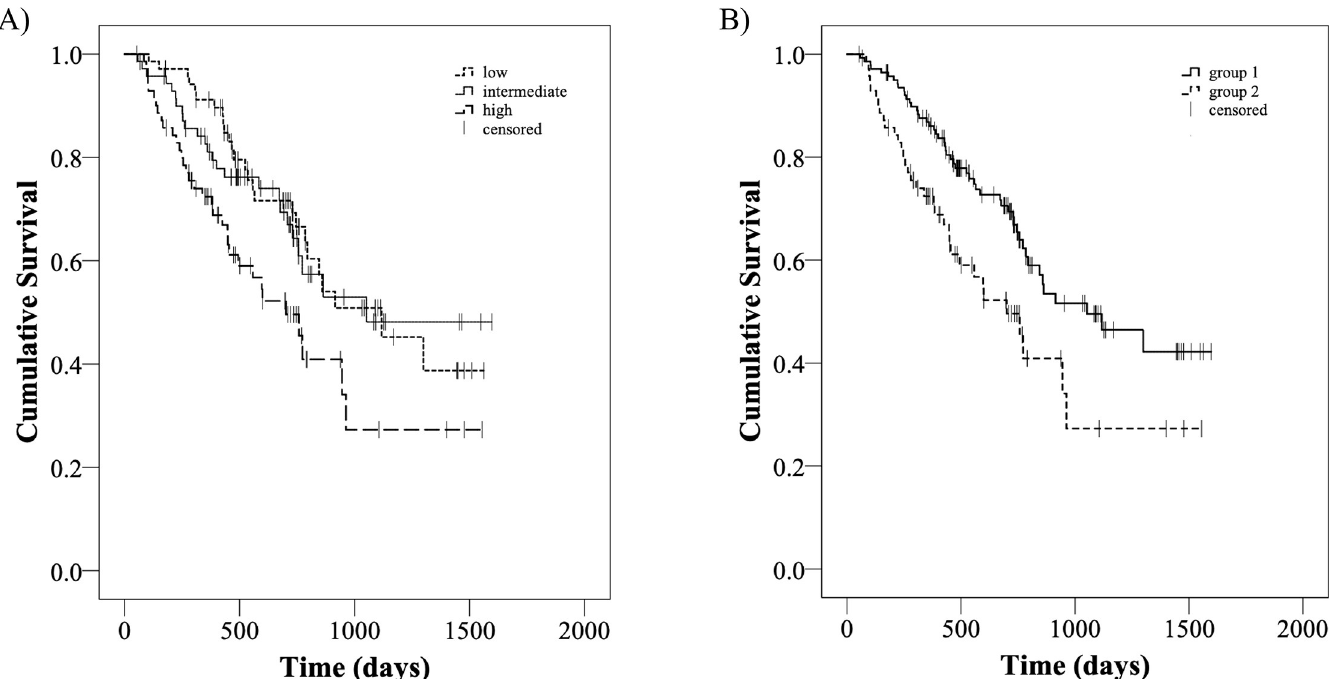
Fig 4. Kaplan-Meier survival curves of the cohort used in this work. Patients divided in a) low-risk group (zone distance varianceGLDZM from 0.15 to 0.85), intermediate-risk group (zone distance varianceGLDZM from 0.86 to 1.69) and high-risk group (zone distance varianceGLDZM from 1.70 to 6.2) based on the prognostic score and b) group 1 (zone distance varianceGLDZM < 1.70) and group 2 (zone distance varianceGLDZM = > 1.70) considering a threshold of zone distance varianceGLDZM. There was a significant difference in OS when dividing in low, intermediate and high-risk group (X2 = 7.37, df = 1, p-value = 0.007) or when using a threshold of zone distance varianceGLDZM (X2 = 7.692, df = 1, p-value = 0.006).